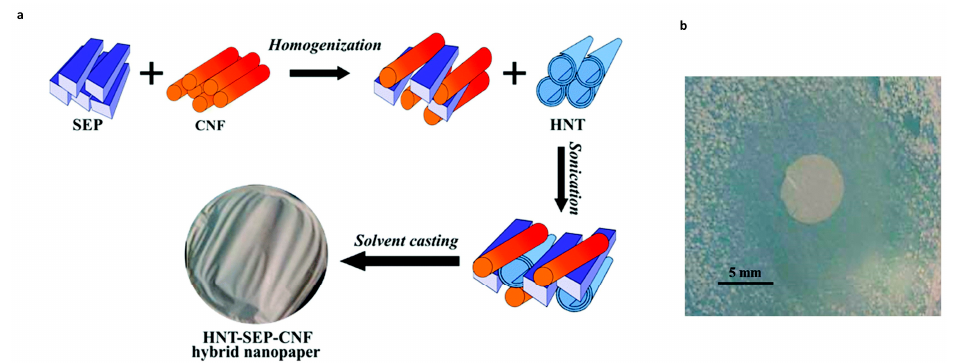
Figure 4. ( a ) Scheme for the synthesis of HNT–SEP–CNF hybrid nanopaper. ( b ) Inhibition zone of the salicylic-acid-loaded HNT–SEP–CNF hybrid nanopaper against gram-positive S. aureus at pH = 5.5. Images adapted from [113].